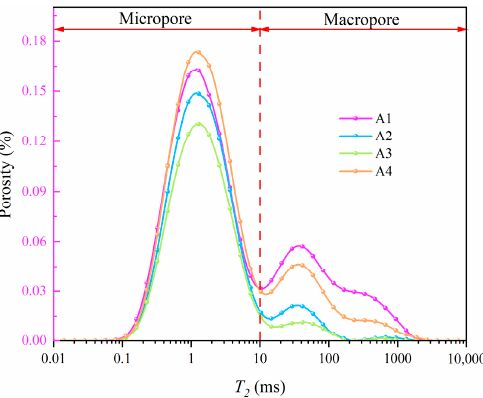
Figure 5. T 2 spectral distribution curves of cement mortars with different fiber contents after 100 freeze-thaw cycles.